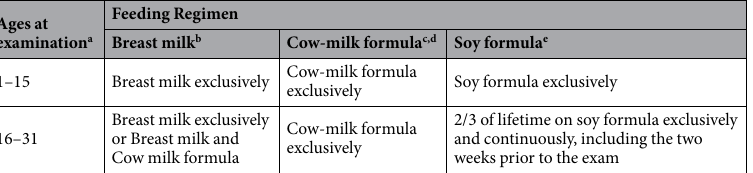
Table 3. Feeding regimen specifications. a Ages 1–15 are newborn up to 48 hours, 1, 2, 3, 4, 5, 6, 7, 8, 9, 10,